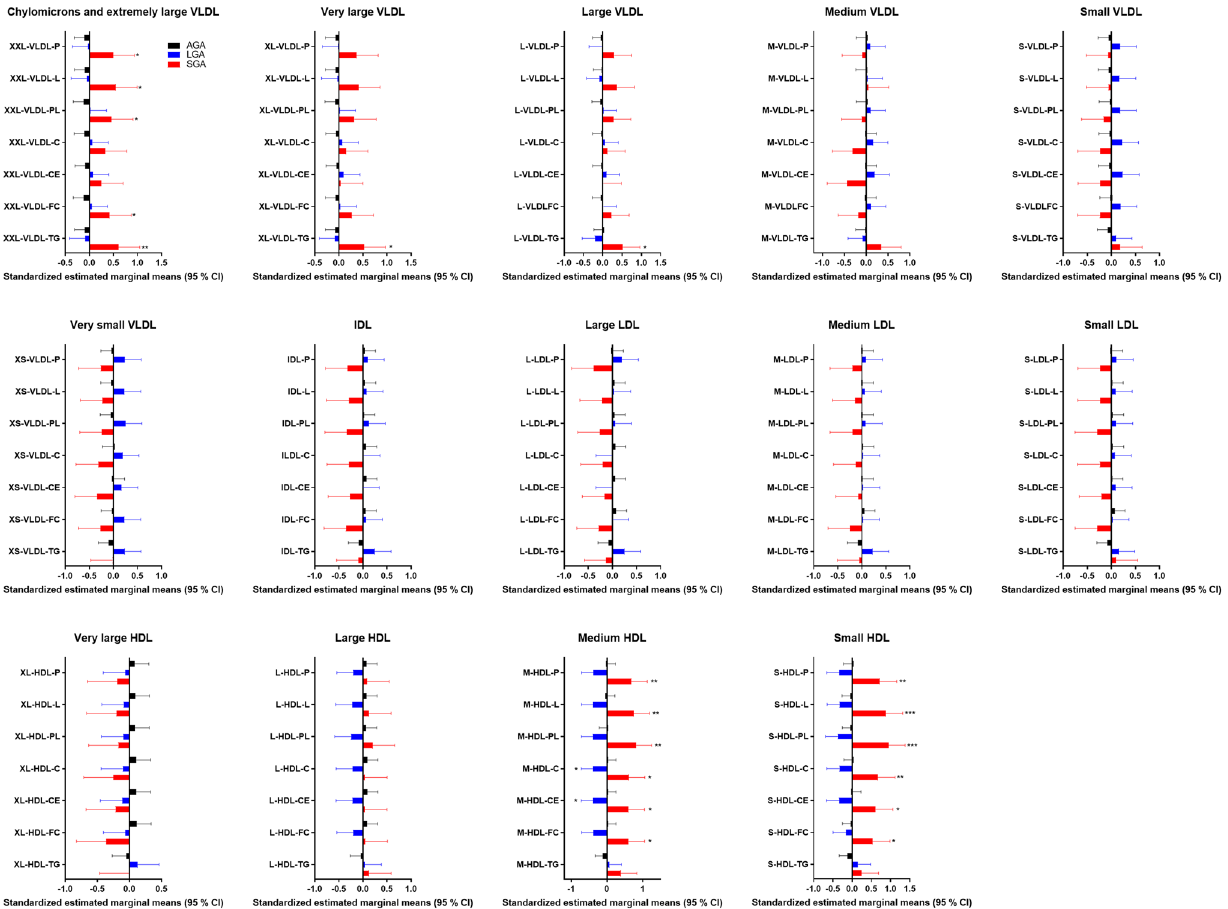
Figure 6. Composition of total (P), lipid (L), phospholipid (PL) cholesterol (C), cholesteryl ester (CE), free cholesterol (FC) and triglycerides (TG) in chylomicrons and very-low-density lipoprotein (VLDL), large density lipoprotein (LDL), intermediate-density lipoprotein (IDL) and high-density lipoprotein (HDL) at week 36–38 between women giving birth to AGA and LGA and AGA and SGA infants. Data is normalized and given as standardized estimated marginal means and 95% confidence interval adjusted for age, fetal sex, gestational diabetes, preeclampsia and BMI at week 14–16. *p < 0.05, **p < 0.01, ***p < expression in the placenta, we used previous RNAseq data from 28 placentas divided according to maternal HDL-C levels (divided by the median) and investigated differentially expressed genes. mRNAs involved in